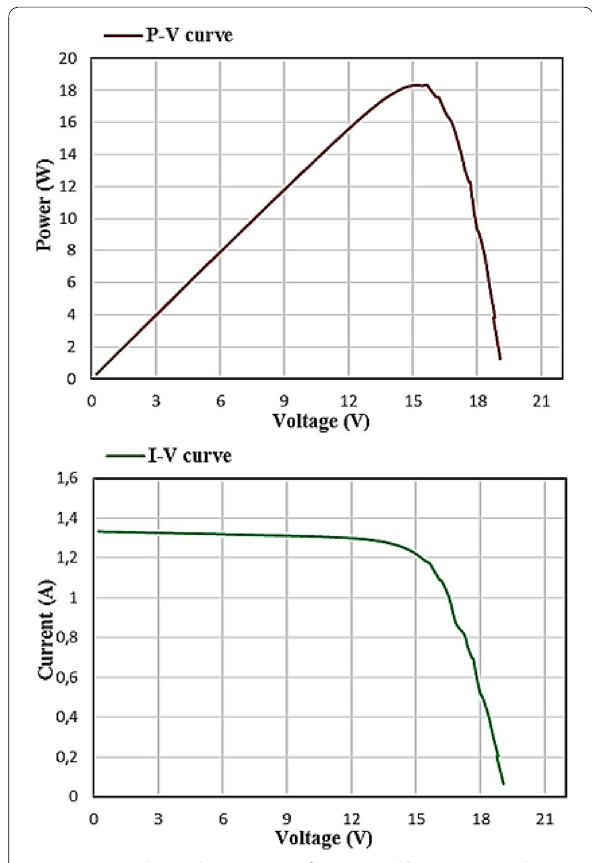
Fig. 15 I – V and P – V characteristics for PV panel by using virtual instrumentation (at T